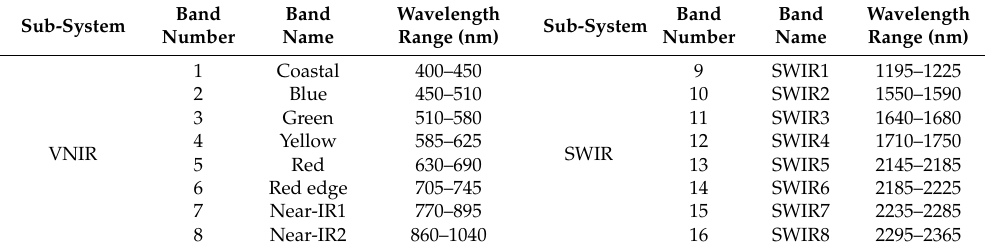
Table 1. Characteristics and wavelength ranges of WorldView-3 (source: Digital Globe